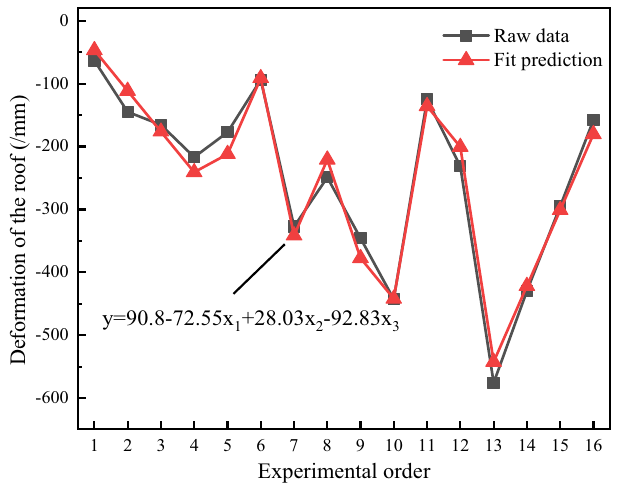
Figure 20. Comparison between the roof regression model and the original experimental data.